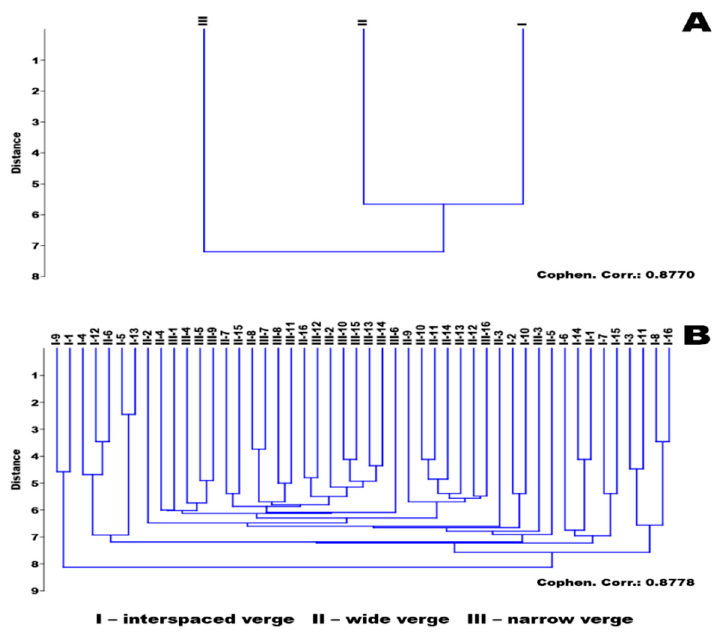
Figure 4. Classification based on the interspaced verge (I) and the wide verge (II) and narrow verge (III) quadrats ( A ): based on occurrences of cumulative average, ( B ): based on occurrences of releves). The number of species was highest in the type I, the interspaced verge (between 80 and 95), compared to surveys of the wide border verge (between 60 and 70) and the narrow verge (between 40 and 45).